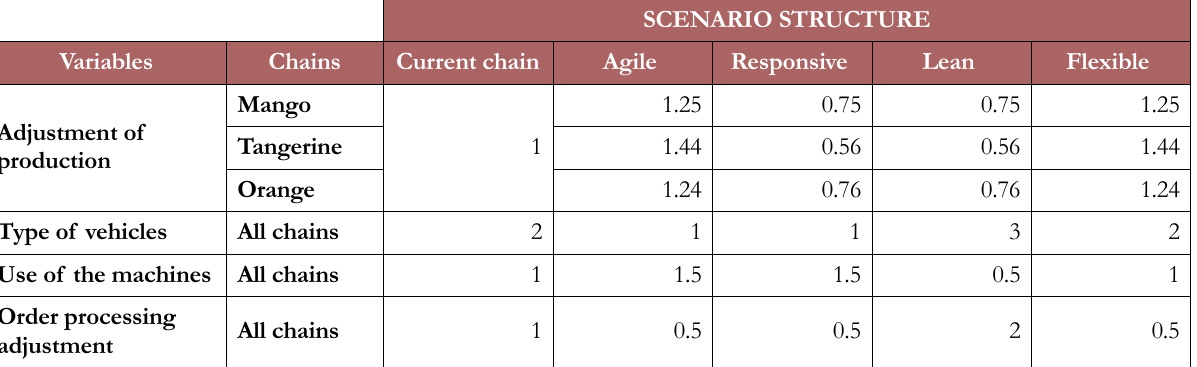
Table 3. Changes of parameters for the